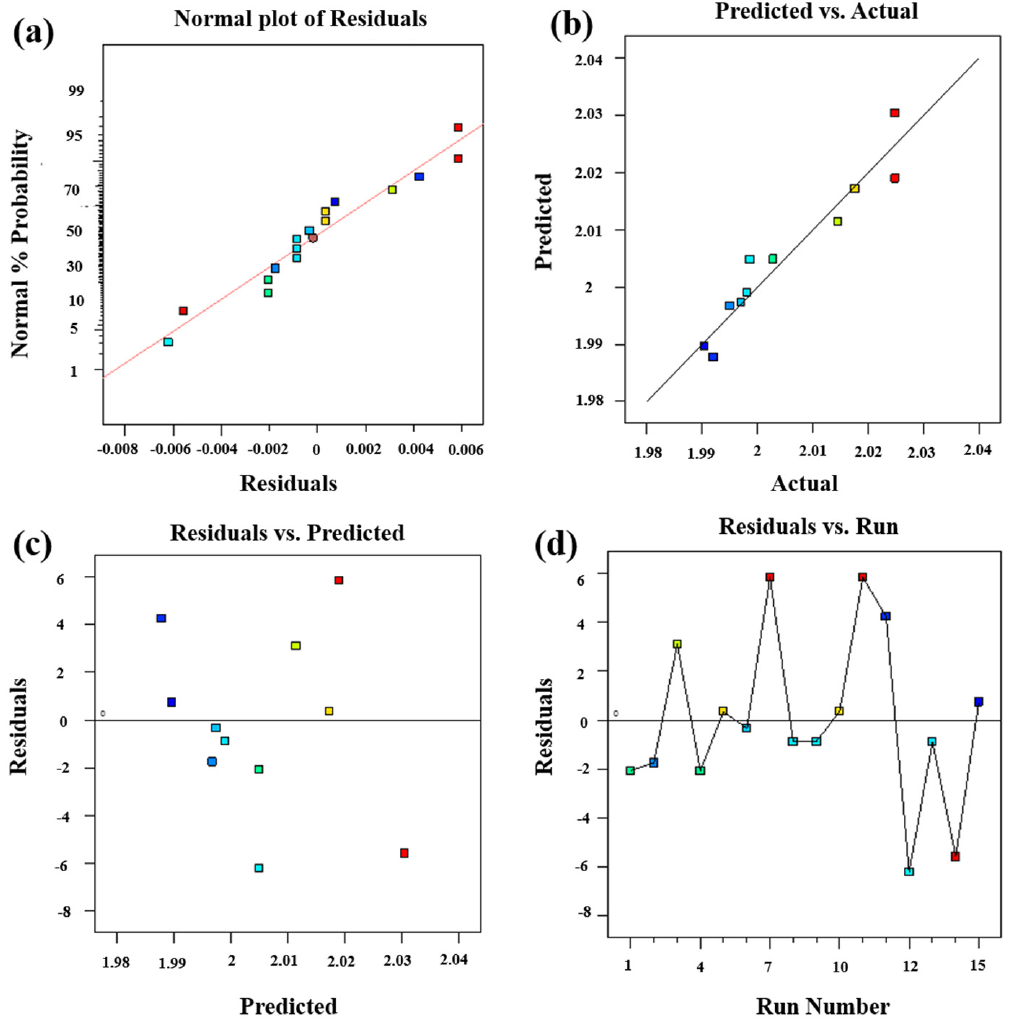
Figure 12. ( a ) Normal plot of residuals ( b ) predicted vs. actual plot ( c ) residuals vs. predicted plot ( d ) residuals vs. run plot.